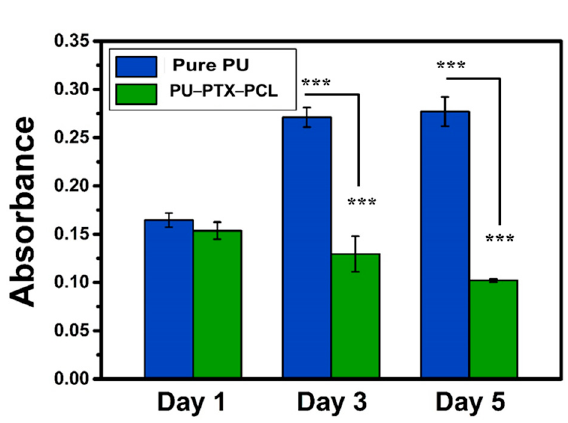
Figure 5. CCK-8 assay of CT26 cultured on pure PU and PU-PTX-PCL. The test was performed on Days 1, 3, and 5, and the drug content in PU-PTX-PCL samples were maintained to 3%. p -values were calculated using t -tests (*** p < 0.001).